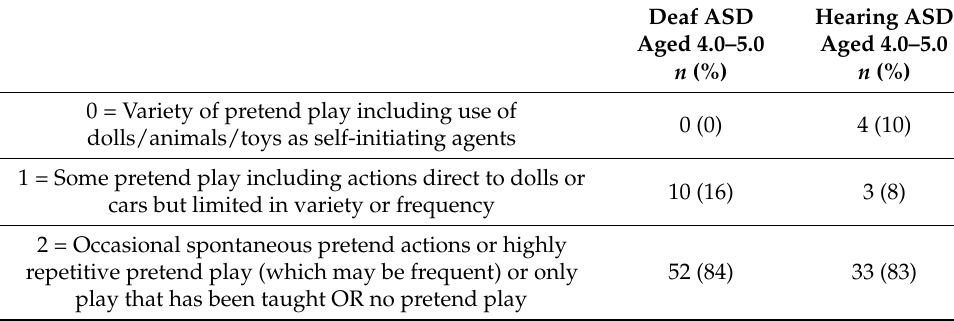
Table 9. Differences in imaginative